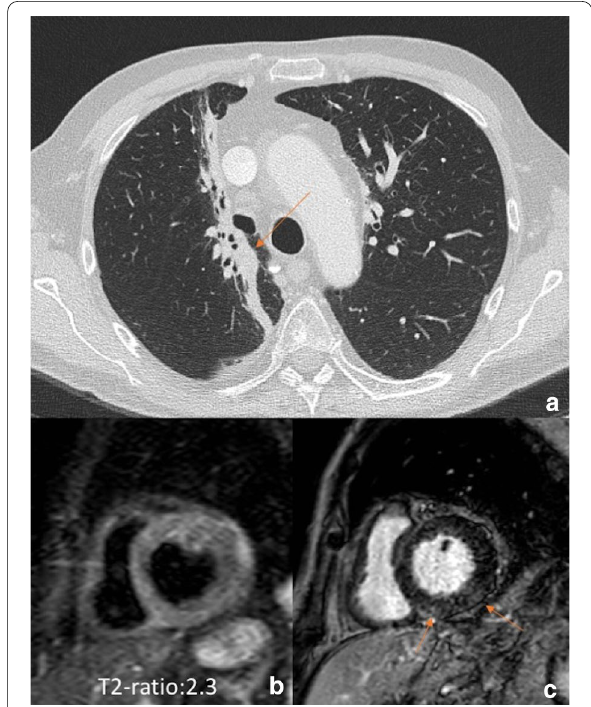
Fig. 13 Myocarditis associated to immune checkpoint inhibitor in a patient with lung cancer. A 67-year-old man with advanced lung adenocarcinoma (stage IIIB) was initially treated with ChT/RT.